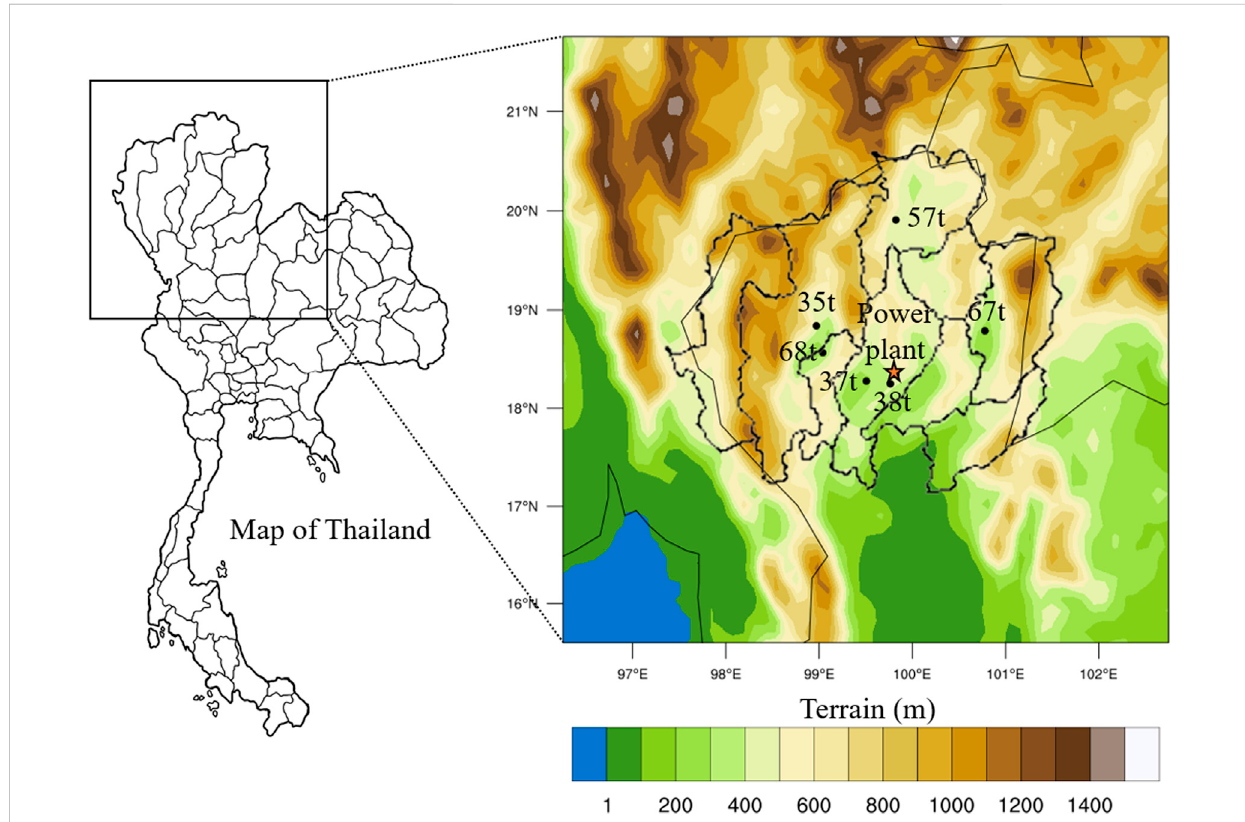
FIGURE 1 WRF-chemdomainwithterrainheightvalues.DotsrefertomonitoringstationsoperatedbythePollutionControlDepartmentofThailandlocatedin Chiang Mai (station ID: 35t), Chiang Rai (station ID: 57t), Lamphun (station ID: 68t), Lampang (station ID: 37t and 38t), Nan (station ID: 67t) provinces and the location of the power plant located in Lampang province is referred by a star